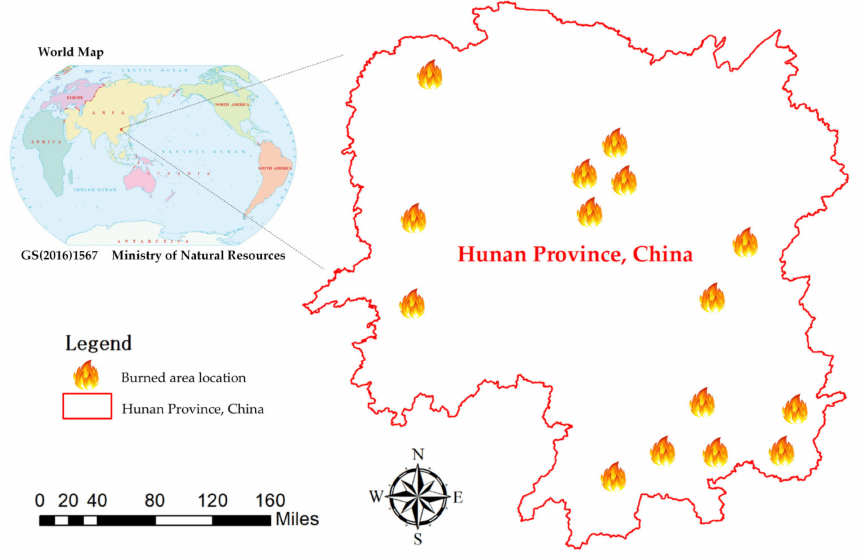
Figure 1. Study site with locations of the fifteen fire-scar sites in Hunan Province,